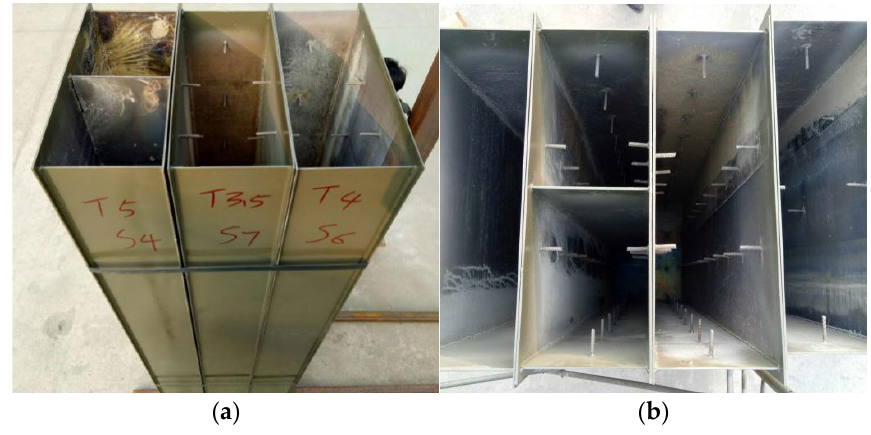
Figure 3. An inside view of steel boxes: ( a ) S-4/7/6; ( b ) S-1/5/2/3.